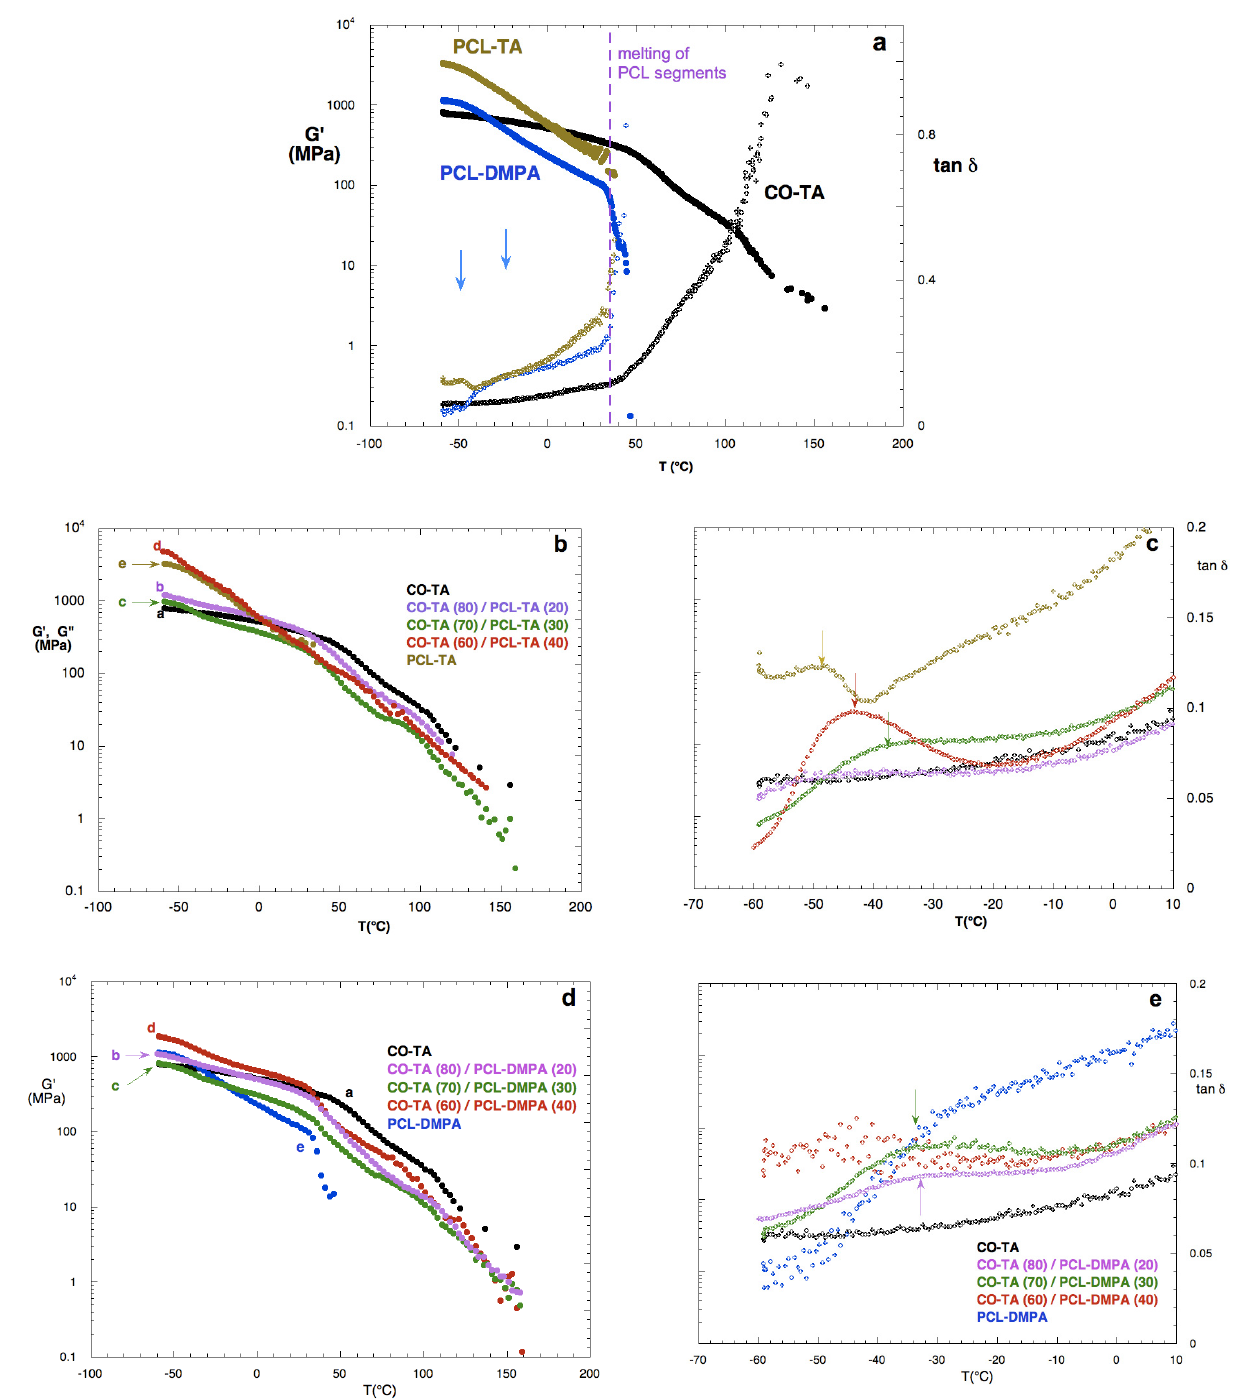
Figure 6. Storage moduli and tan δ curves for neat WBPUs ( a ), CO-TA/PCL-TA films ( b , c ), and CO-TA/PCL-DMPA films ( d , e ).